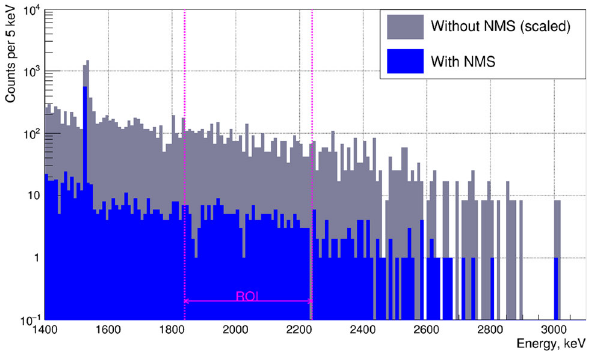
Fig. 9 Normalized energy spectra of the bare BEGe detector without NMS (grey area) and with NMS (blue) Table 2 Count rates in the different energy regions with and without NMS. SF in the ”beta region” is calculated taking into account a long- term decrease of the count rates (see Sect. 3.1 and Fig. 10)